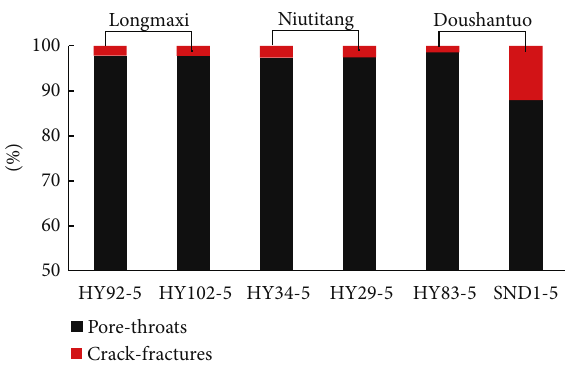
Figure 8: Pore and crack proportions in di ff erent